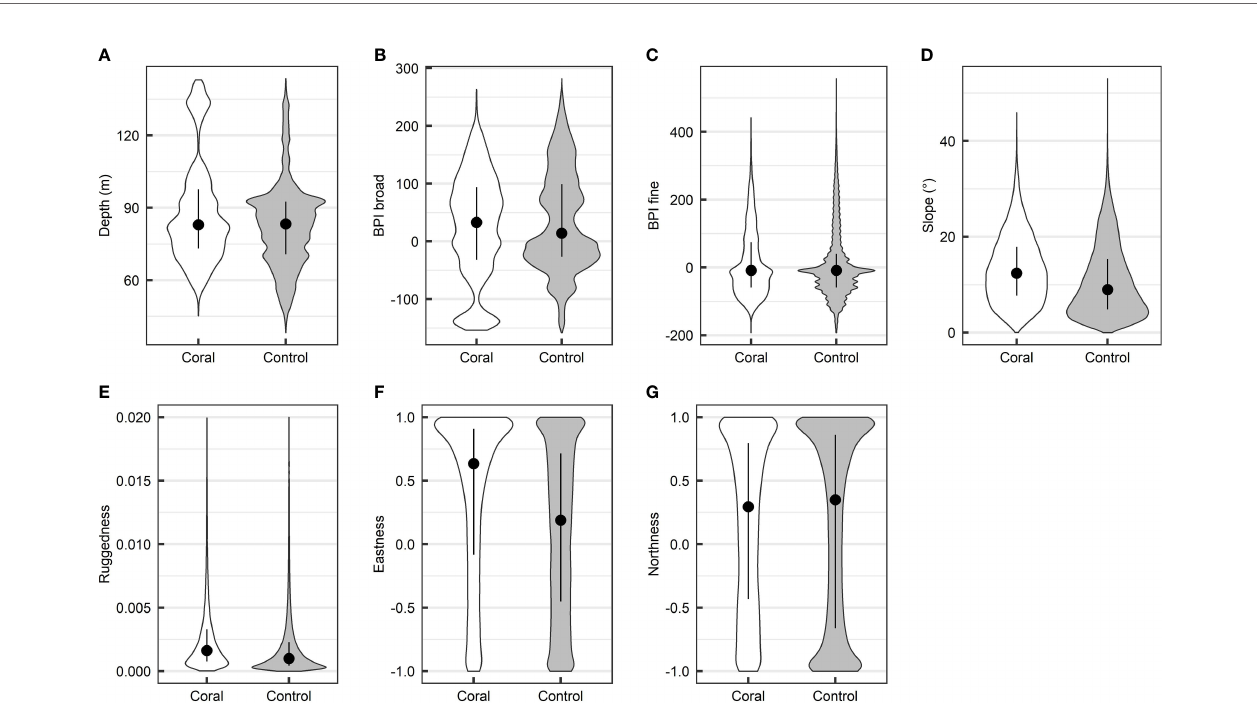
FIGURE 5 | Geomorphometric comparison of coral ( n = 24,388 grid cells) and non-coral (control; n = 122,963 grid cells) regions on the Tautra Ridge. The data were obtained from areas classi fi ed as “ coral ” and “ control ” by the convolutional neural network (CNN) classi fi er (see Estimation of CWC Reef Distribution in SAS Imagery ). The fi gure shows the class-speci fi c median, interquartile range and probability density of seven multibeam echo sounding (MBES)-derived sea fl oor